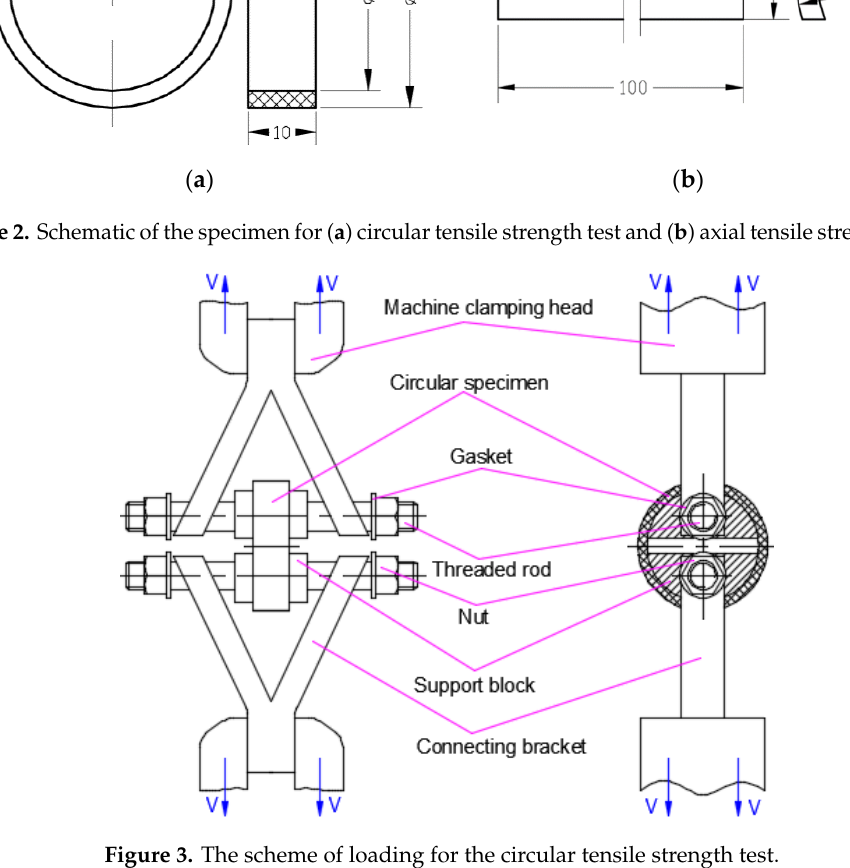
Figure 3. The scheme of loading for the circular tensile strength test.